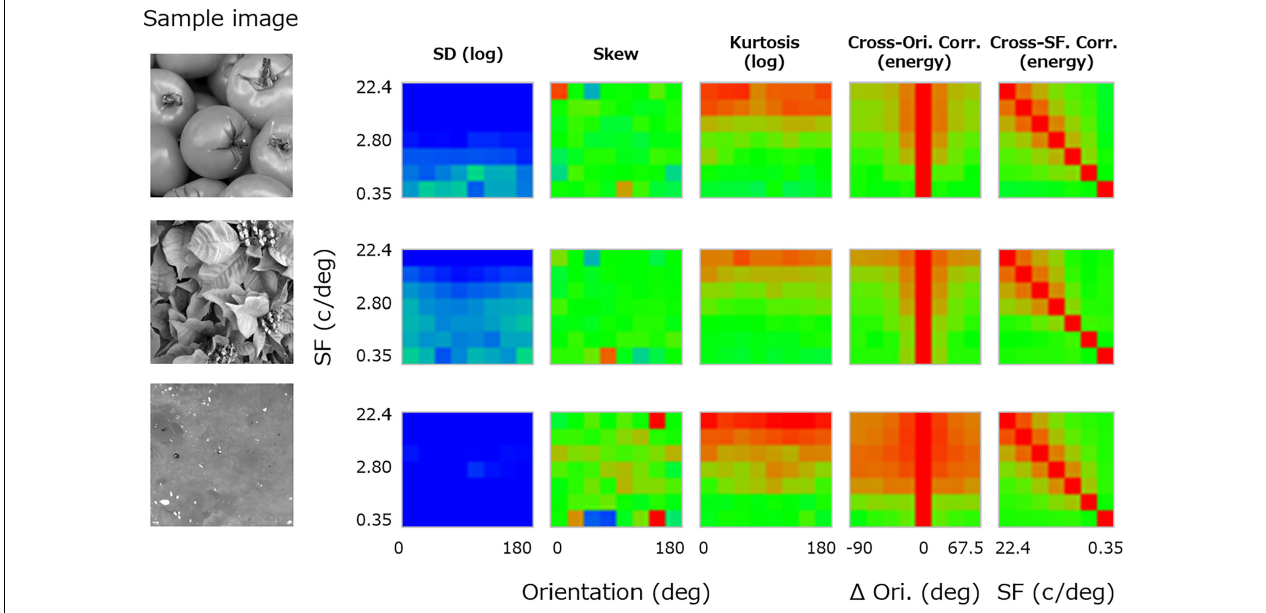
FIGURE 2 | Image statistics calculated for a sample texture image (far left). From the left, the central three panels show the log SD, skewness, and log kurtosis plotted as functions of the spatial frequency and orientation of the subband. The two right-most panels show the cross-orientation energy correlation plotted as a function of the spatial frequency and the orientation (Ori) difference between subbands, and the cross-frequency energy correlation plotted as a function of the spatial frequency (SF) and the paired SF. The color of each pixel represents the value of the statistics, separately scaled for each class of